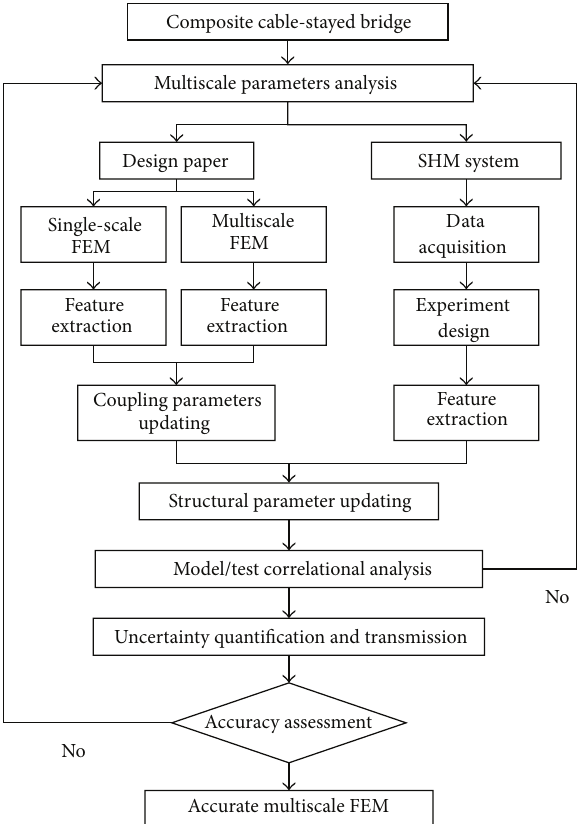
Figure 3: The multiscale FEM validation procedure based on SHM system.